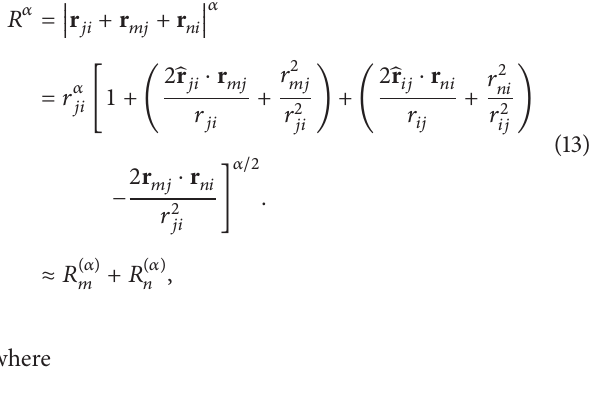
Figure 2: Bistatic RCS (E-plane) of an LHM sphere with radius 10cm and 𝜀 𝑟 = 𝜇 𝑟 = −1−𝑗0.001 operating at frequencies of 0.6 GHz, 1.14GHz, 1.68GHz, and 2.22 GHz. The arrow indicates the incidence direction of a plane wave.